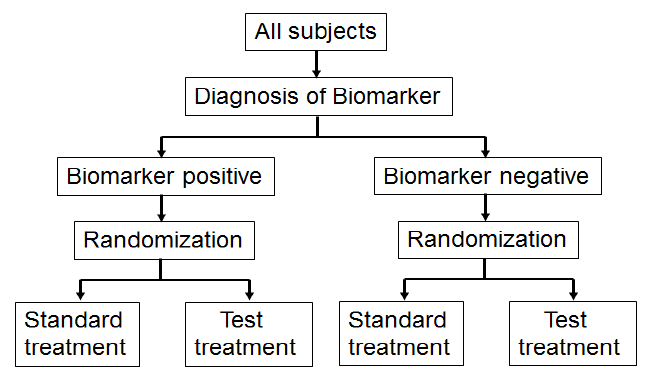
Figure 2. Biomarker by treatment interaction